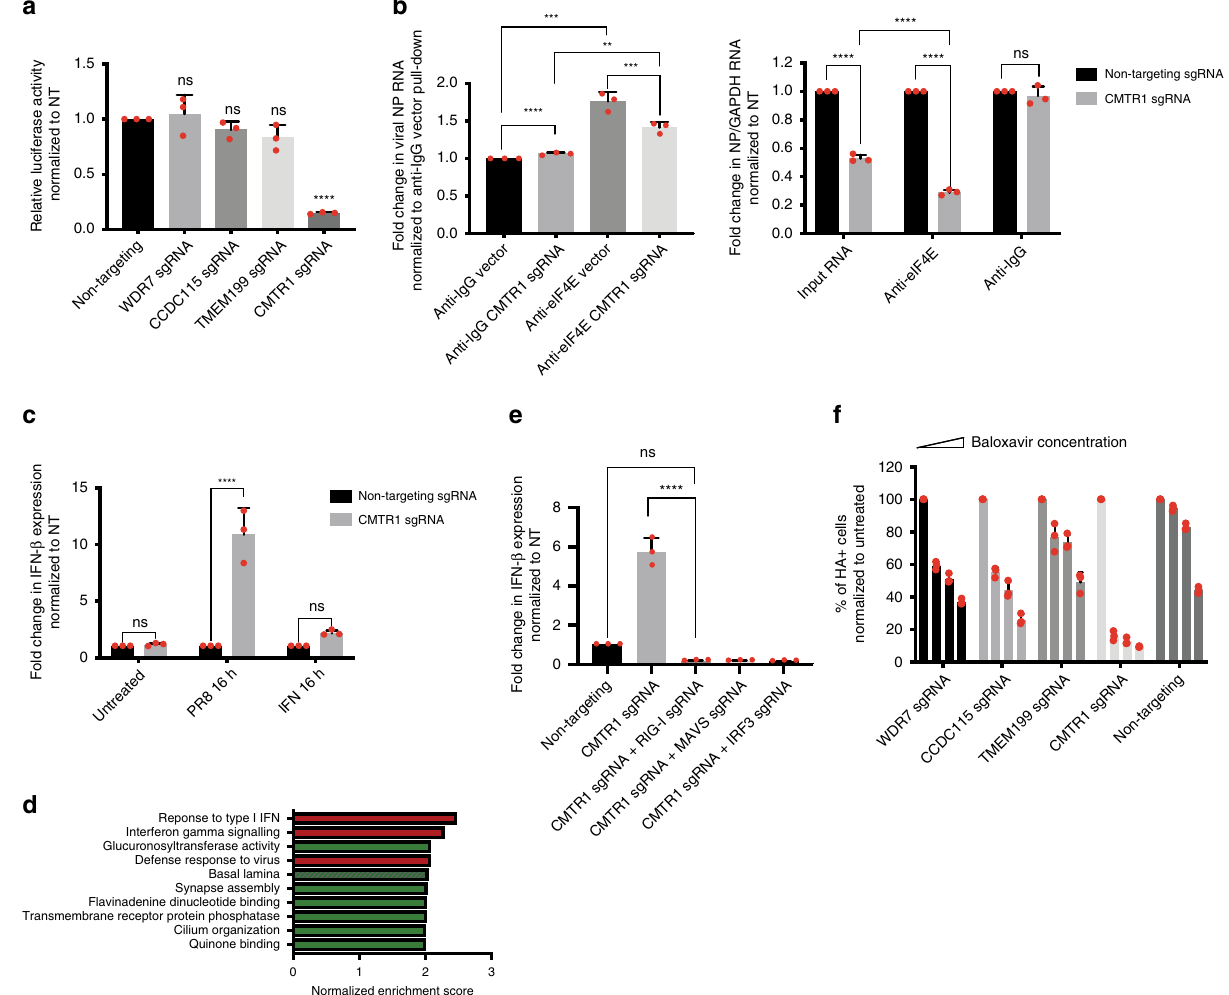
Fig. 7 Loss of CMTR1 inhibits viral replication and up-regulates anti-viral genes. a A549 cells transduced with gene-speci fi c or non-targeting sgRNAs were transfected with PR8 PA, PB1, PB2, and NP plasmids together with green-Renilla and Luciferase reporter plasmids for 24 hours. Luciferase activity was measured and normalized to A549 cells transduced with non-targeting sgRNA. Error bars represent standard deviations from three independent experimental replicates. b A549 cells transduced with CMTR1 or non-targeting sgRNA were infected with PR8 virus, in vivo crosslinked, lysed and immunoprecipitated with either anti-eIF4E or anti-IgG antibody to extract capped cellular and viral RNA. qRT-PCR was performed to monitor the relative abundance of PR8 NP RNA. (Left): Fold change in NP RNA levels normalized to anti-IgG non-targeting sgRNA pulldown. (Right): Fold change in NP relative to GAPDH RNA levels normalized to non-targeting sgRNA. Error bars represent standard deviations from three independent experimental replicates. c Fold change in IFN- β relative to GAPDH mRNA levels measured by qRT-PCR. A549 cells transduced with CMTR1 or non-targeting sgRNA were either mocked treated, infected with PR8 virus or treated with 200 U/ml IFN- β for 16 h. Fold change was normalized to A549 cells transduced with non-targeting sgRNA. Error bars represent standard deviations from three independent experimental replicates. d Gene Ontology (GO) enrichment analysis showing the top 10 up-regulated gene categories in A549 cells transduced with CMTR1 sgRNA versus non-targeting sgRNA after PR8 virus infection. IFN-related and antiviral gene categories are colored in red. e Fold change in IFN- β relative to GAPDH mRNA levels measured by qRT-PCR. A549 cells were transduced with CMTR1 sgRNA alone or together with sgRNA targeting RIG-I, MAV or IRF3 and infected with PR8 virus. Fold change was normalized to cells transduced with non-targeting sgRNA. Error bars represent standard deviations from three independent experimental replicates. f A549 cells transduced with gene- speci fi c or non-targeting sgRNA were pre-treated with 0, 1, 5 or 10 nM of Baloxavir followed by PR8 virus infection. Y-axis shows the percentage of HA-positive cells normalized to untreated cells. Error bars represent standard deviations from three independent experimental replicates. **** P = 0.0001, ** P < 0.01, by one-way ANOVA